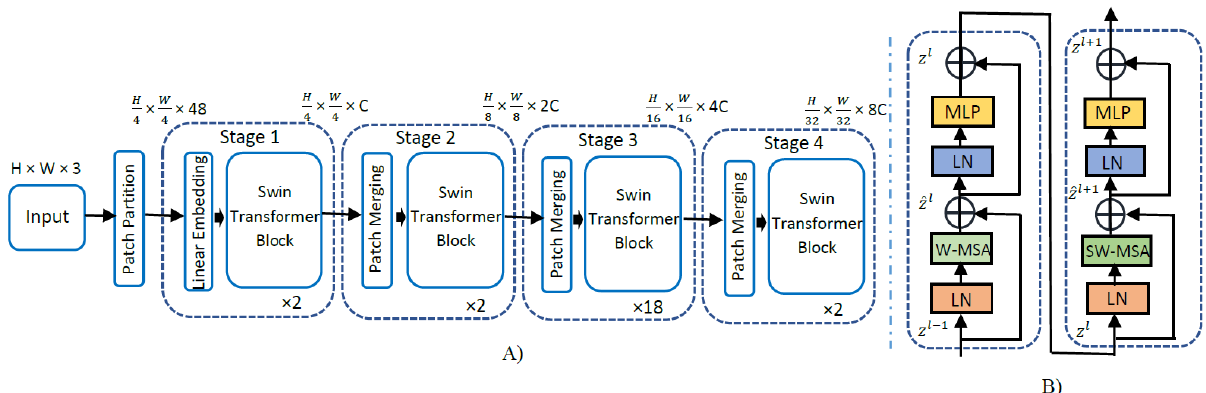
Figure 2. ( A ) The architecture for the swin transformer base model. ( B ) Two successive swin transformer blocks (notations given with Equations (1)–(4)). LN: layer normalization, W-MSA: window (regular) multi-head self-attention, SW-MSA: shifted window multi-head self-attention, MLP: multi-layer perceptron. Input image size is 224 × 224 × 3, C = 128, and layer numbers = { 2, 2, 18, 2 }